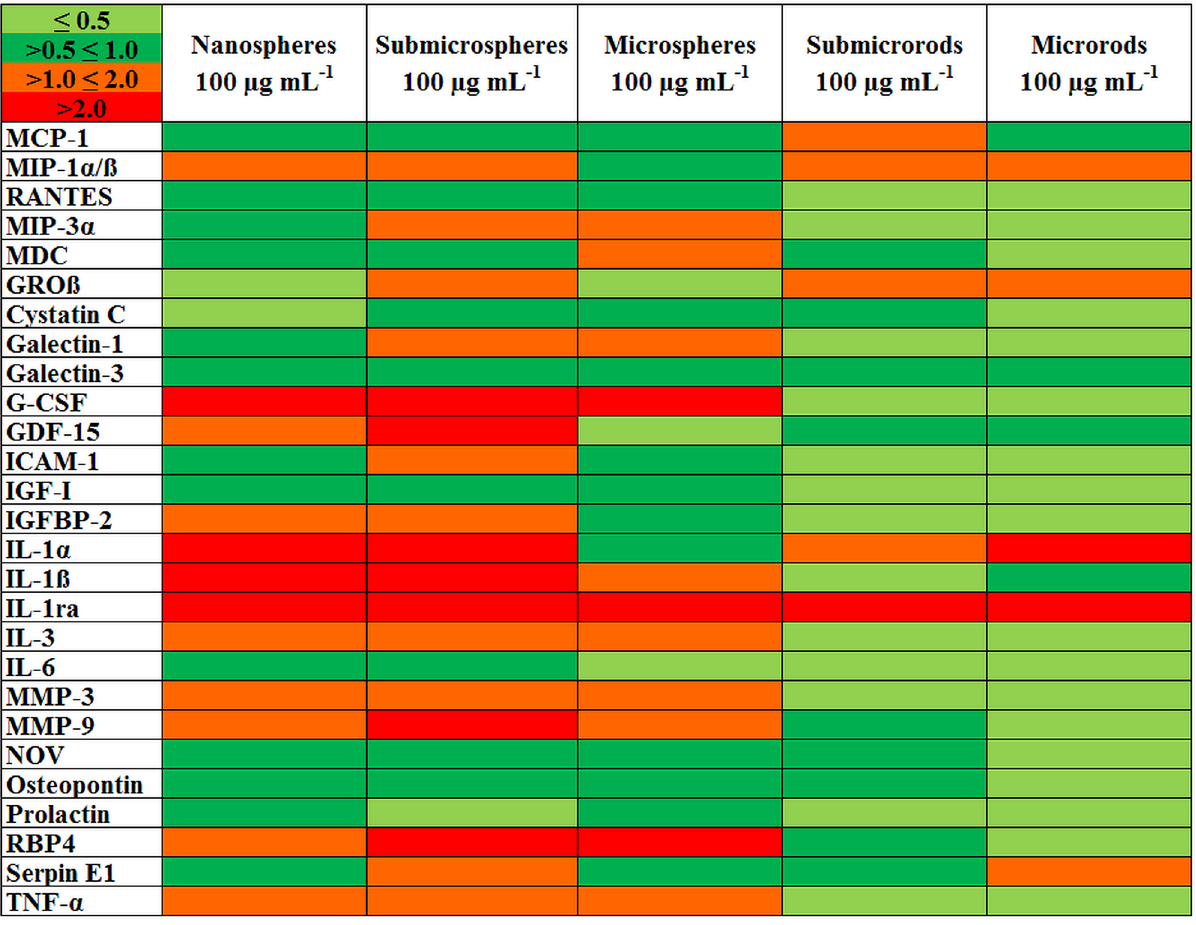
Figure 10. Heat map of 27 bioactive factors of the proteomic repertoire of NR8383 alveolar macrophages after 16 h of exposure to different unfunctionalized silica particles at 100 µg mL −1 (subtoxic level) as obtained by protein microarrays. Each row of the heat map represents the expression of one factor relative to its expression in supernatants of NR8383 cells without particle exposure (control). The green colors represent lower, the red colors represent higher expression of factors relative to the control. The color intensity scale shows fold changes at the upper left corner of the